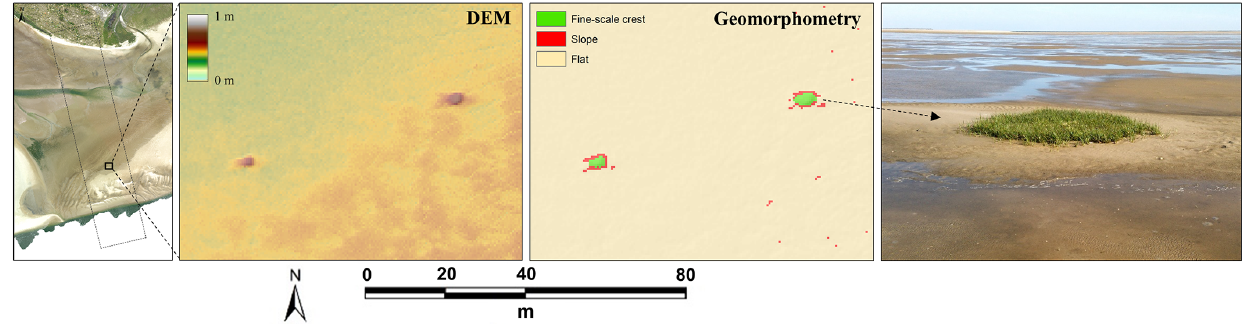
Figure 11. Vegetated mounds on the intertidal flat are clearly visible in the DEM and classified as fine-scale crests in the geomorphometric classification. To the right is an image of one of the mounds.